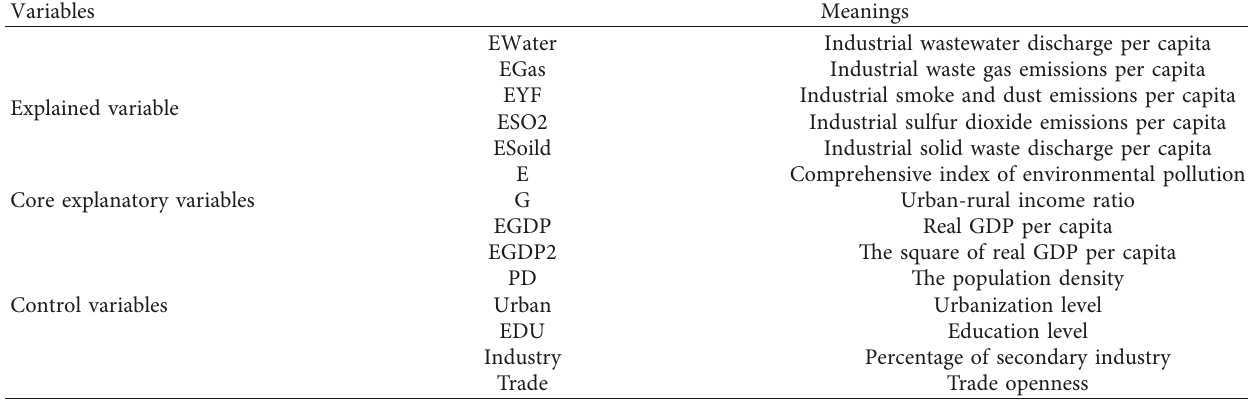
Table 1: Variables symbols and meanings.